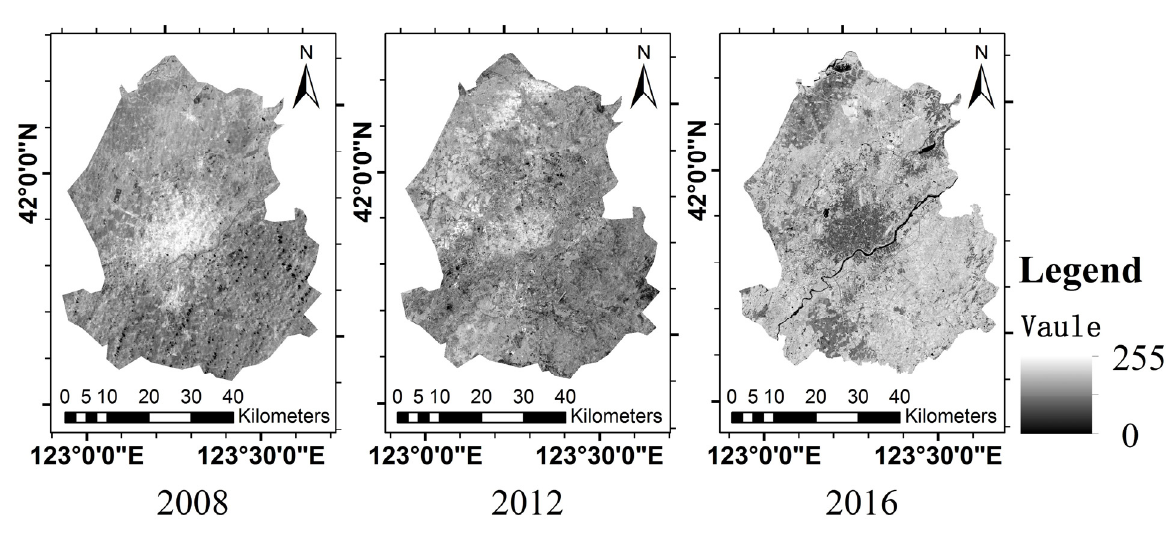
Figure 3. Shenyang NDISI index image.